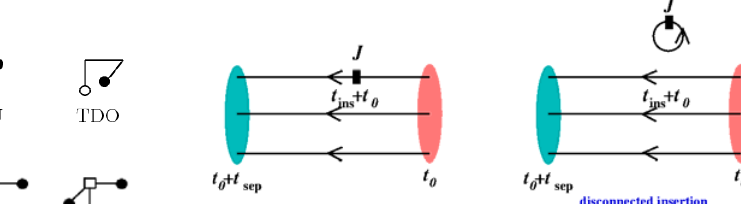
Figure 2. Diagrammatic representations of contributions to 3- point functions. (Left) The external current J occurs on one of the three quark lines connecting the baryon source (pink) to the baryon sink (blue). (Right) So-called disconnected contributions in which the insertion of the current J does not connect to the three quark lines between the baryon source and sink, but is in- volved in a separate sea quark loop.